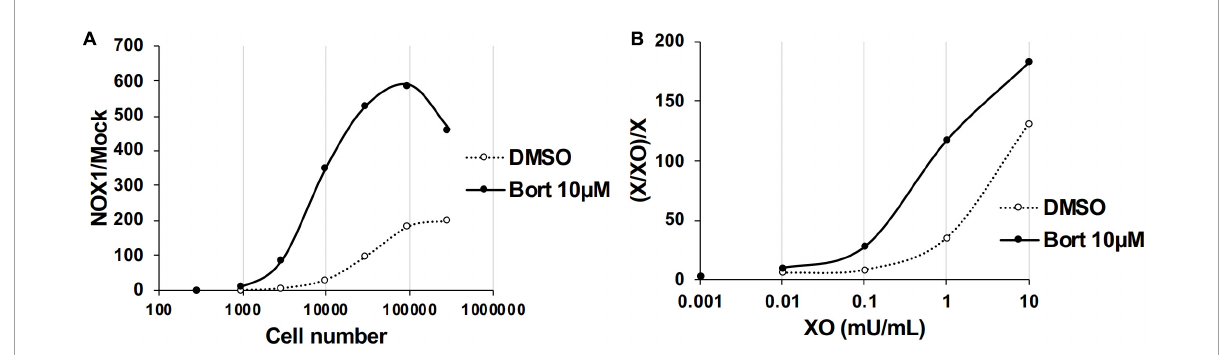
FIGURE3 Bortezomib improved the detection of lower levels of superoxide. (A) The ratio of total L-012 luminescence during 30 min in 300 - 3 × 10 5 NOX1-expressing cells to that in mock-transfected cells. (B) The ratio of total L-012 luminescence during 30 min in the X/XO system (0.001 – 10 mU/ml) to that in xanthine-containing medium (X, 0.2 mM). The total volume of each experiment was 0.1 ml. Representative data of two independent experiments are